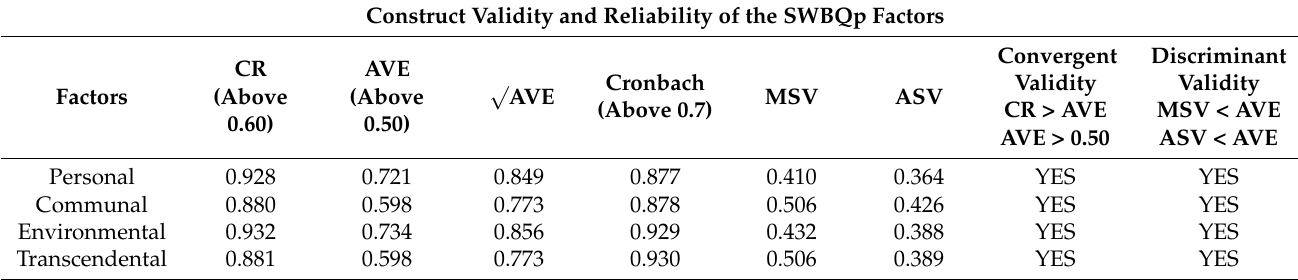
Table 4. Construct validity and reliability of the SWBQp